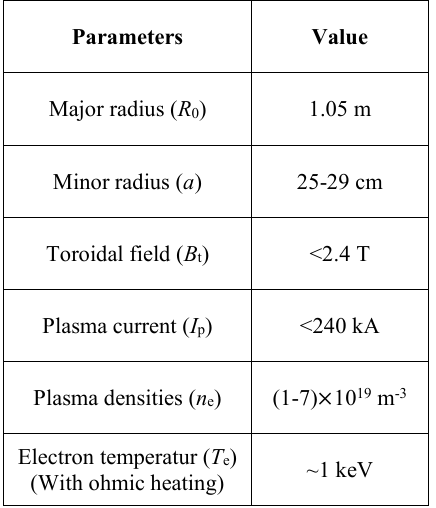
Table 1. Basic operation parameters of